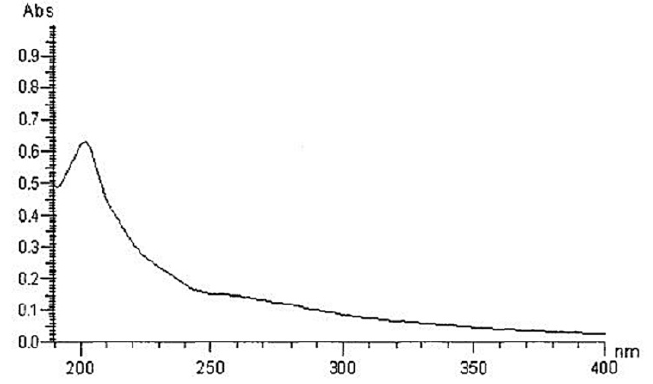
Figure 1. The UV spectra of polysaccharide fractions of Ganoderma lucidum .